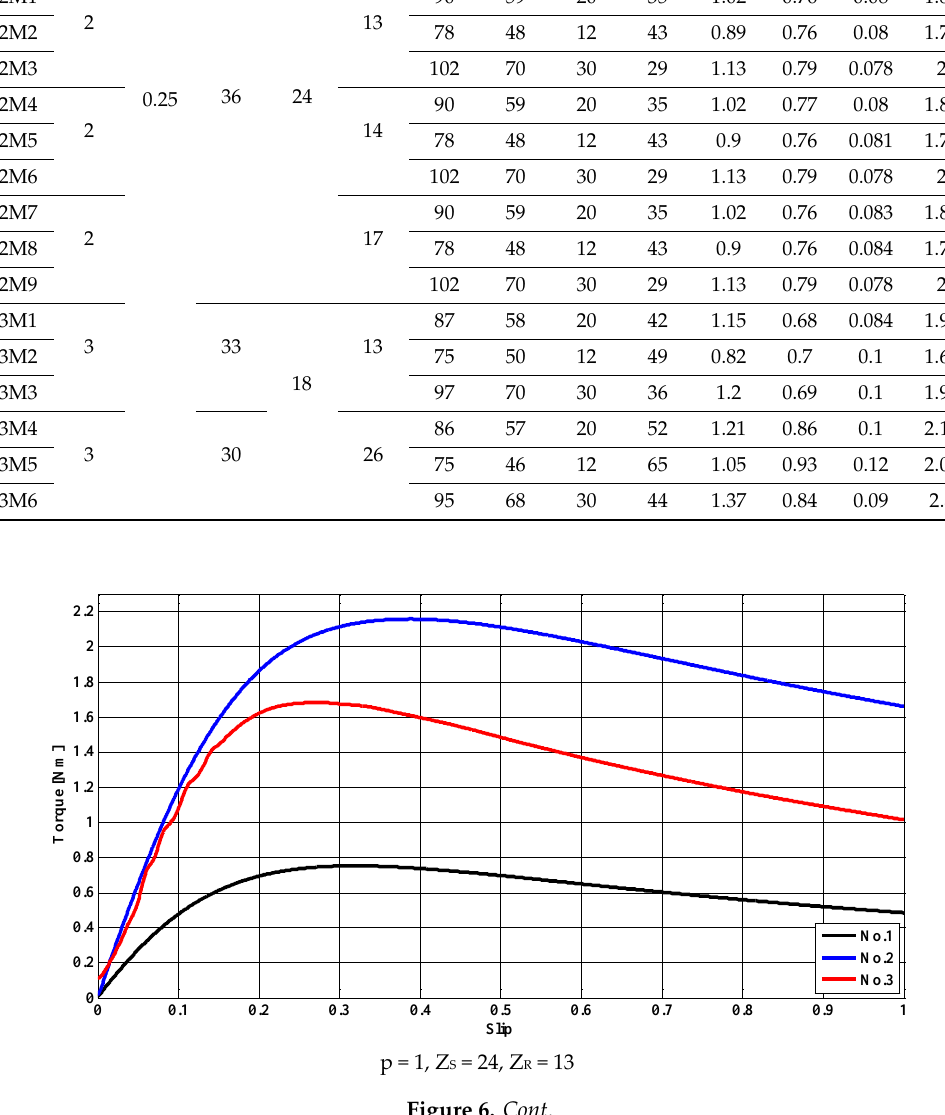
Table 3. Parameters of the initially designed IMs (e =